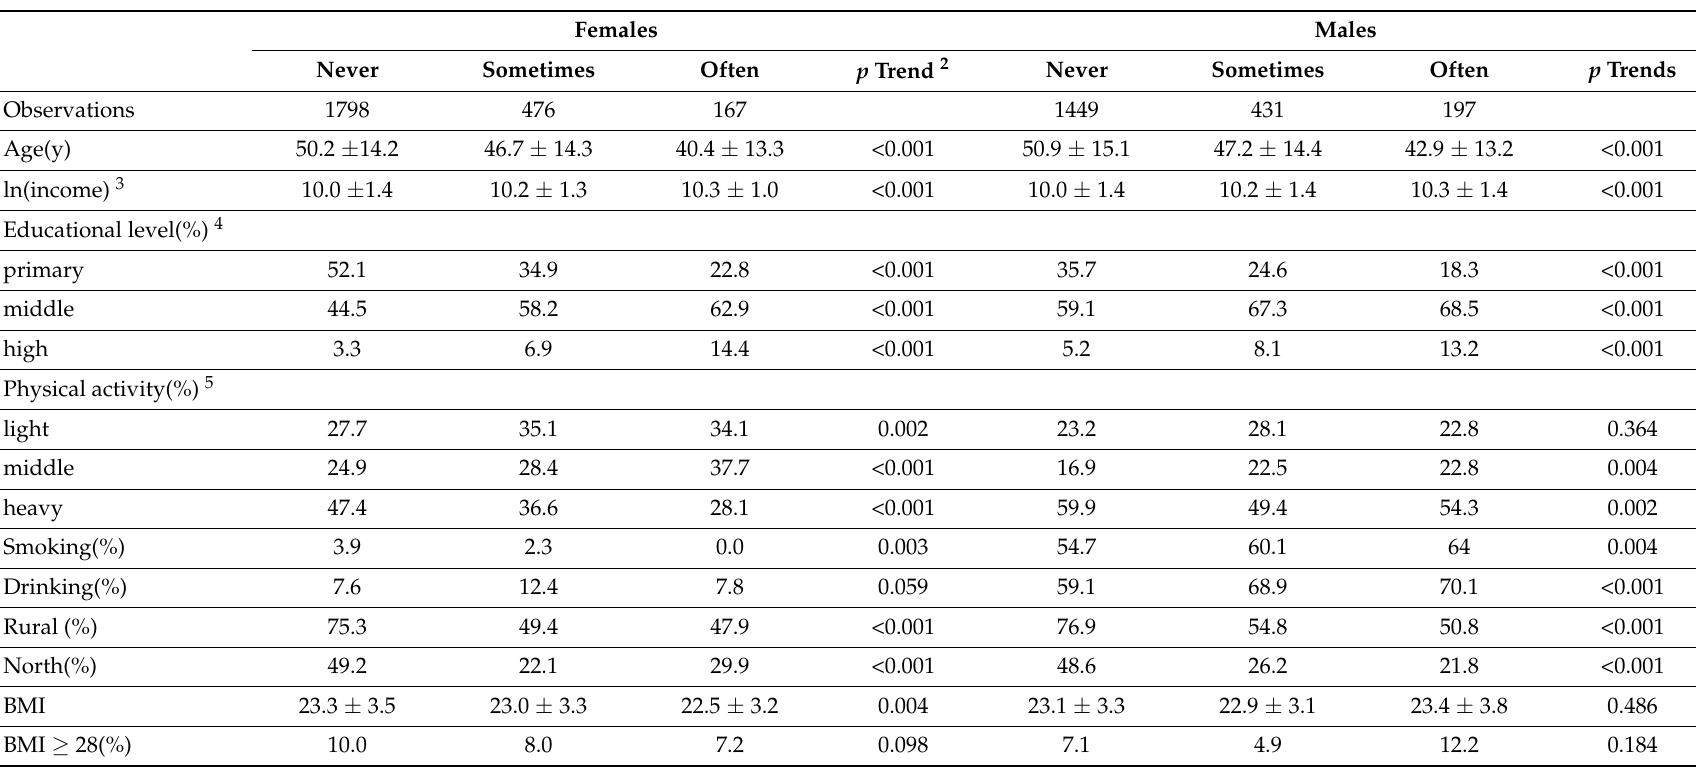
Table 1. Characteristics of participants by frequency of EAFH 1 and sexes. Females Males Never Sometimes Often p Trend 2 Never Sometimes Often p